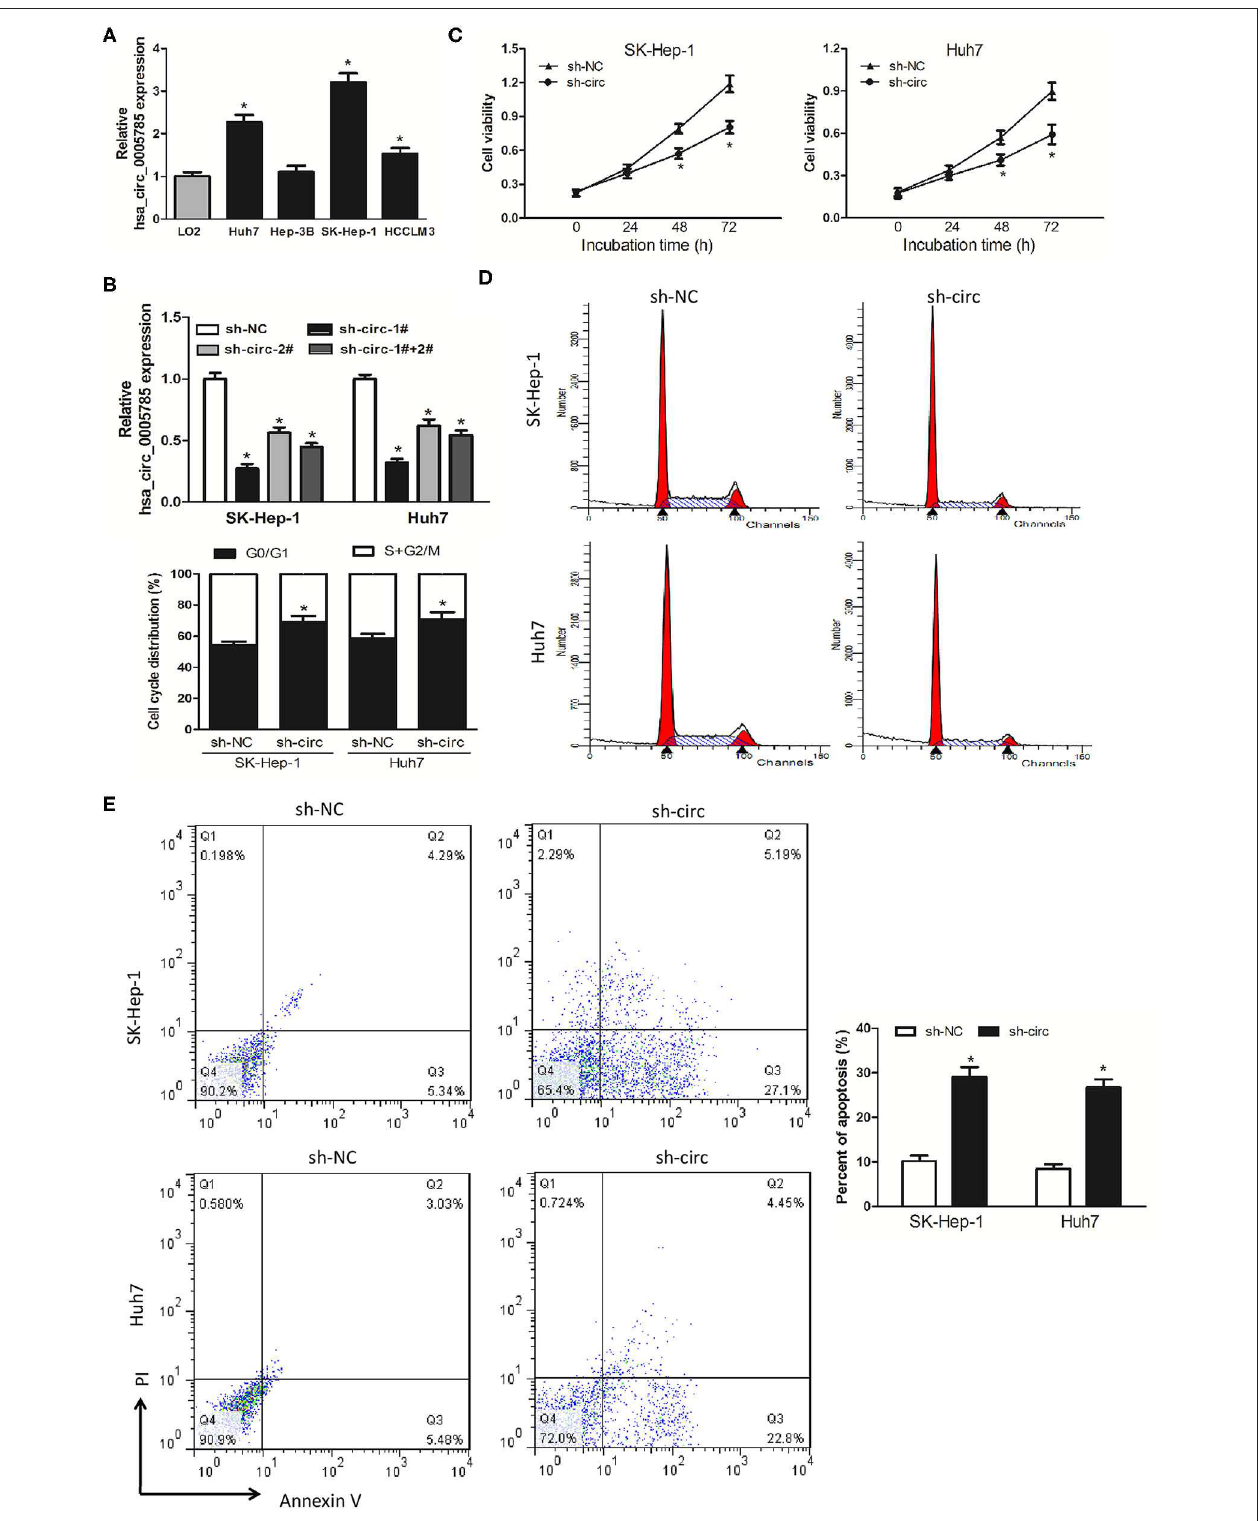
FIGURE 2 | Knockdown of hsa_circ_0005785 inhibits HCC cell growth in intro. (A) qRT-PCR analyses of hsa_circ_0005785 expression in 4 HCC cell lines and a normal hepatic cell line LO2. (B) qRT-PCR detection of RNA interference efficiency targeting hsa_circ_0005785 was examined in sh-NC (non-targeting control),